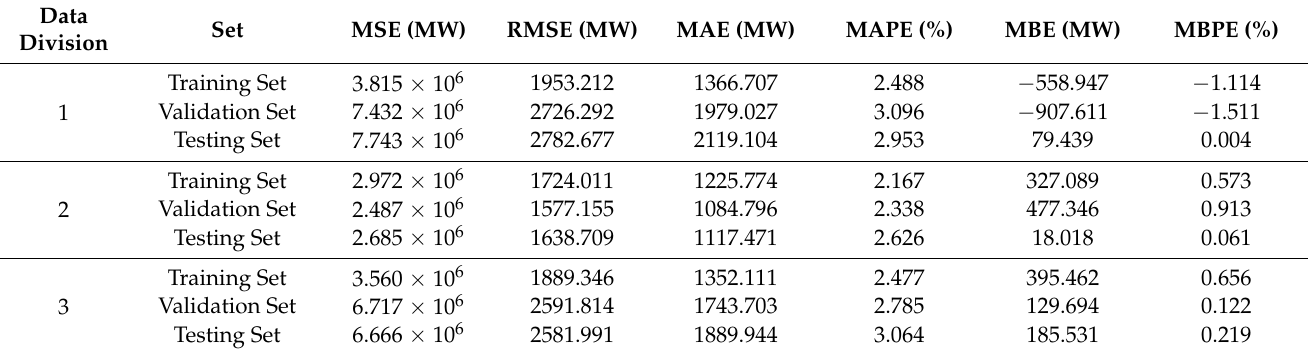
Table 2. Performance comparison metrics for each data division in training, validation, testing datasets.